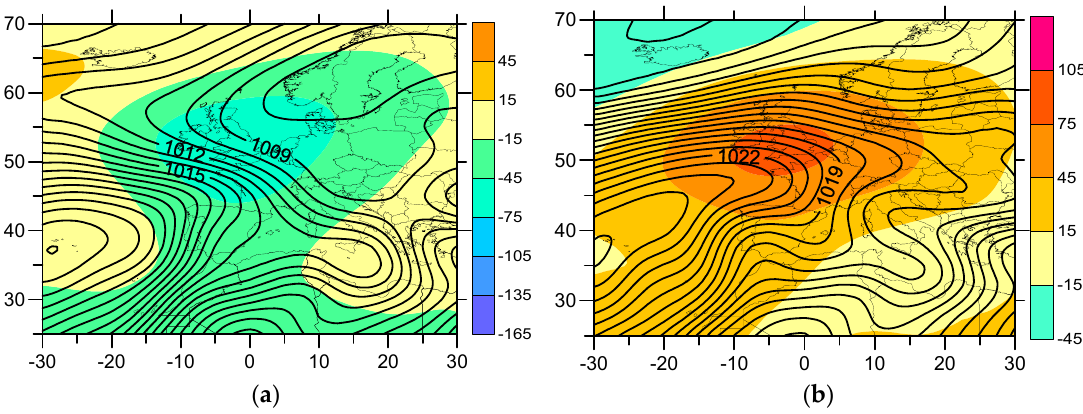
Figure 8. ( a ) MSLP (hPa) and Z500 (gpm) anomalies for the 5 months with the most negative values of iPCN2; ( b ) MSLP (hPa) and Z500 (gpm) anomalies for the 5 months with the most positive values of iPCN2.